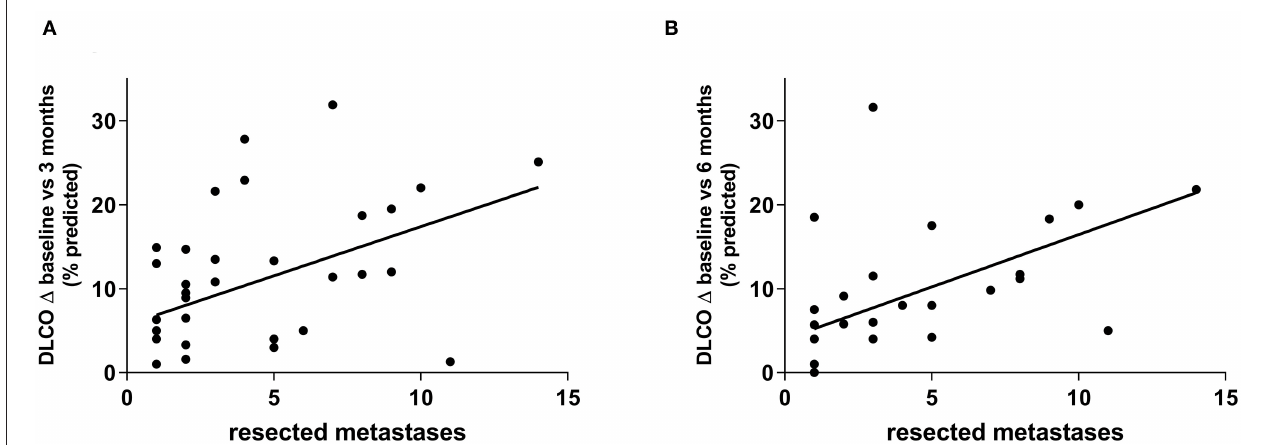
FIGURE 3 | DLCO decline showed the greatest correlation with the number of resected metastases. This was observed after 3 months ( r = 0.45, p = 0.006) (A) as well as after 6 months ( r = 0.42, p = 0.02) (B)